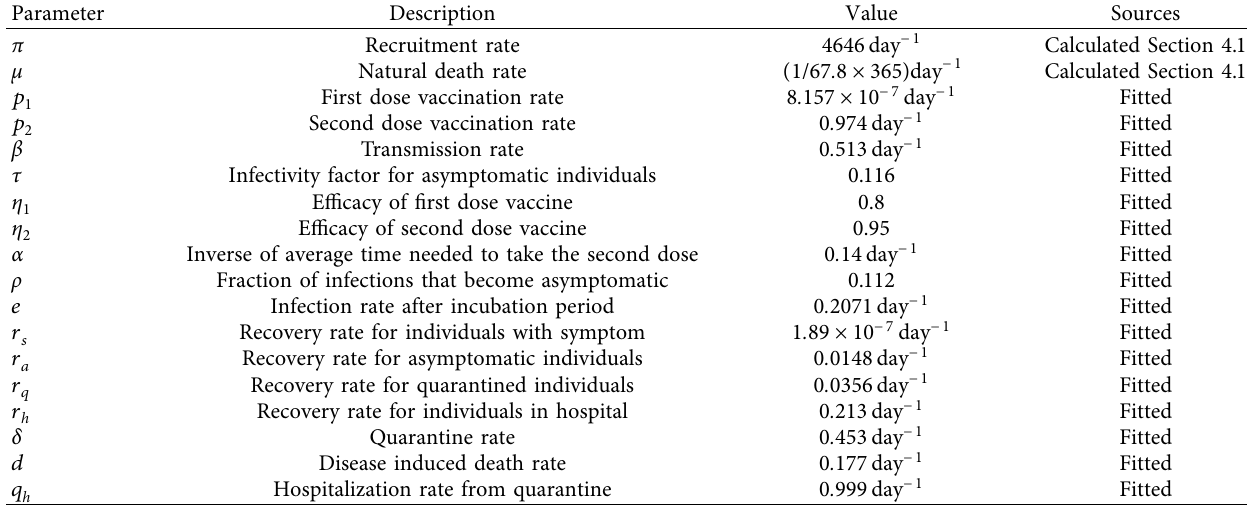
Table 2: Parameter description and their baseline values used in the model (2).